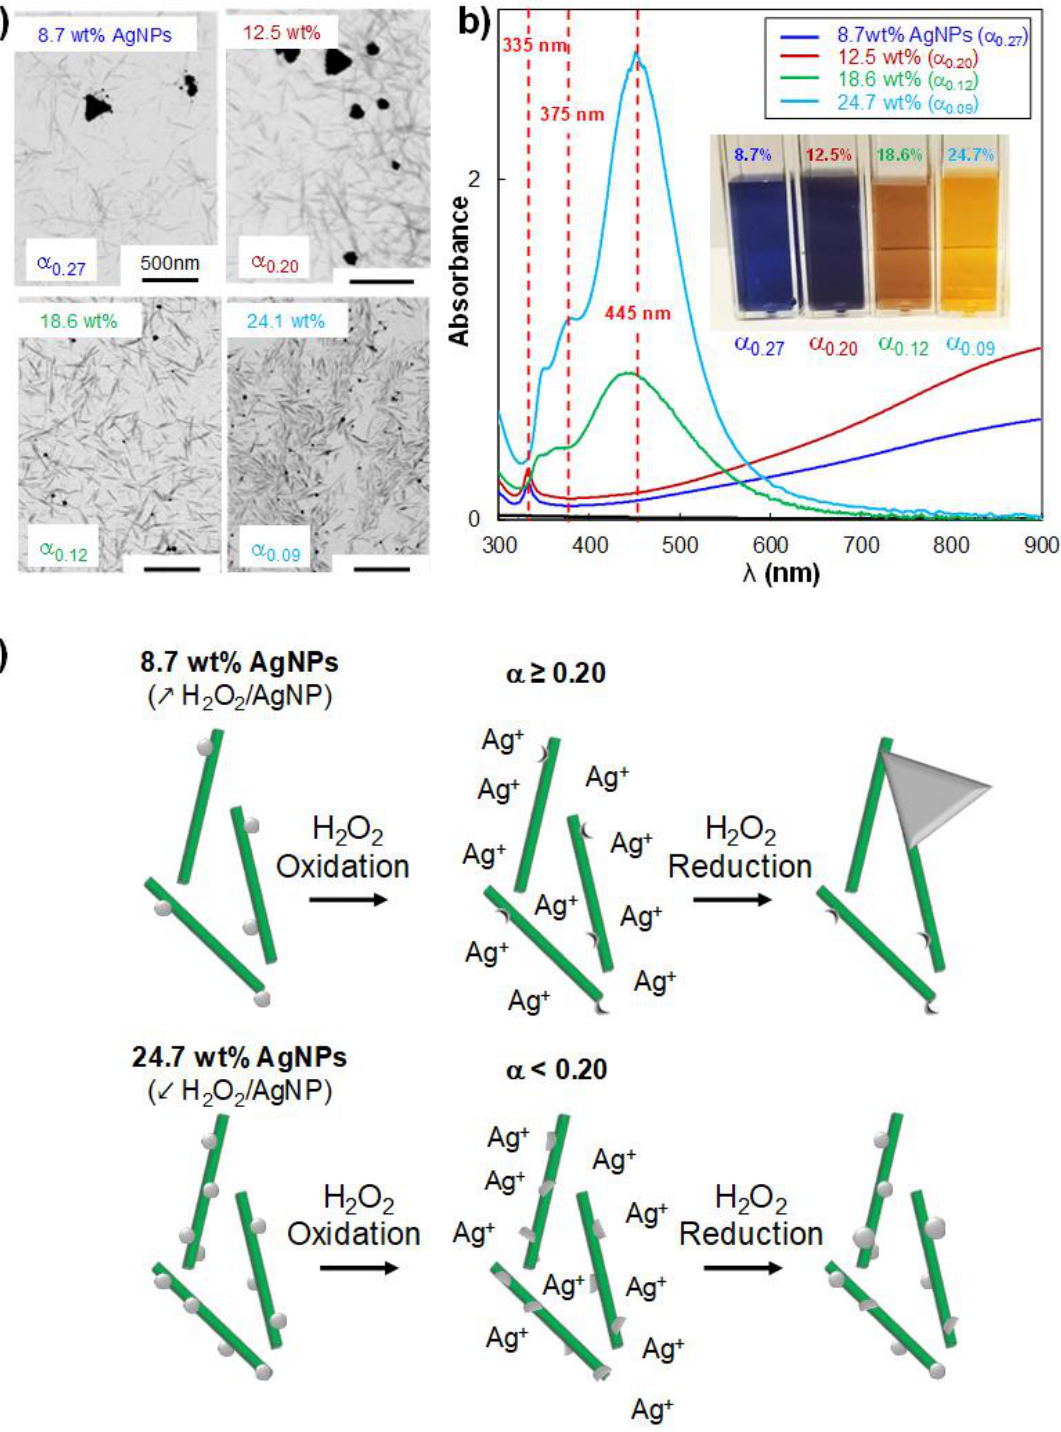
Figure 3. ( a ) STEM images and ( b ) UV-Vis spectra of CNC / AgNP_H 2 O 2 hybrids at various AgNP_H 2 O 2 contents where 160 µ L of H 2 O 2 were added. In STEM images, bar scales of 500 nm are indicated. ( c ) schematic representation of the H 2 O 2 oxidation-reduction mechanism in hybrids at low and high AgNP contents (i.e., α parameter above and below the critical value of 0.20).